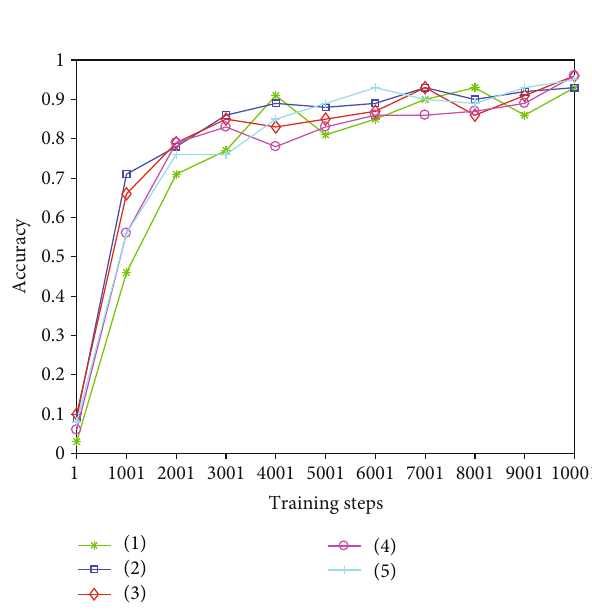
Figure 8: Fitting process for accuracy.